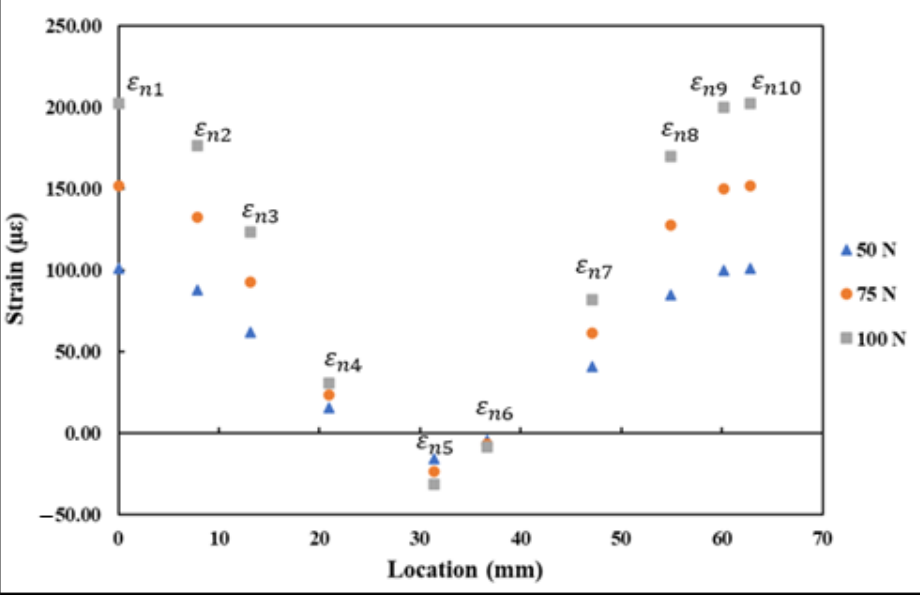
Figure 12. 𝜀 𝑛1 − 𝜀 𝑛10 transformed strains under flexural loading.